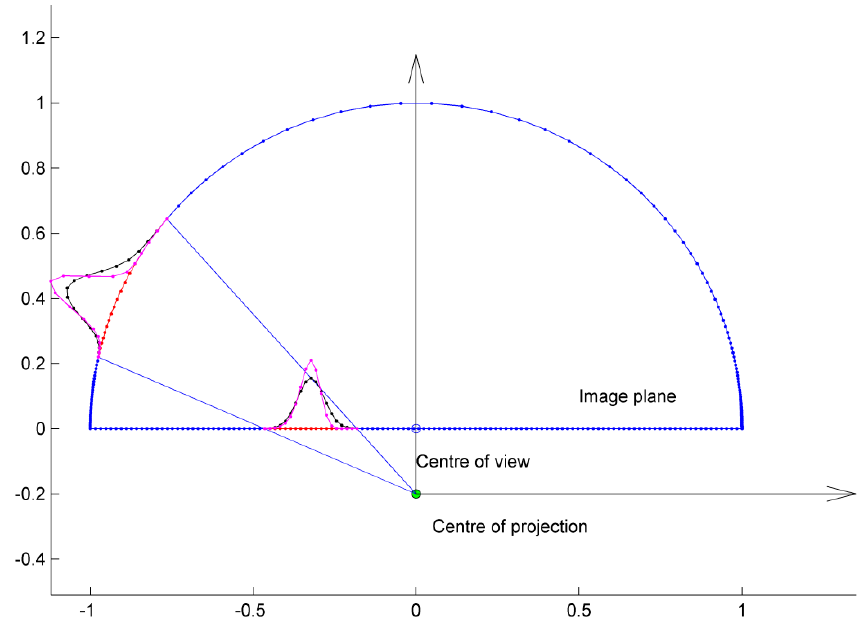
Figure 3. The basic concept of fisheye image formation, involving a (semi) spherical lens and central projection on the image plane. The difference between Euclidean distance between pixels on the image plane and geodesic distance (on the spherical lens) becomes apparent.